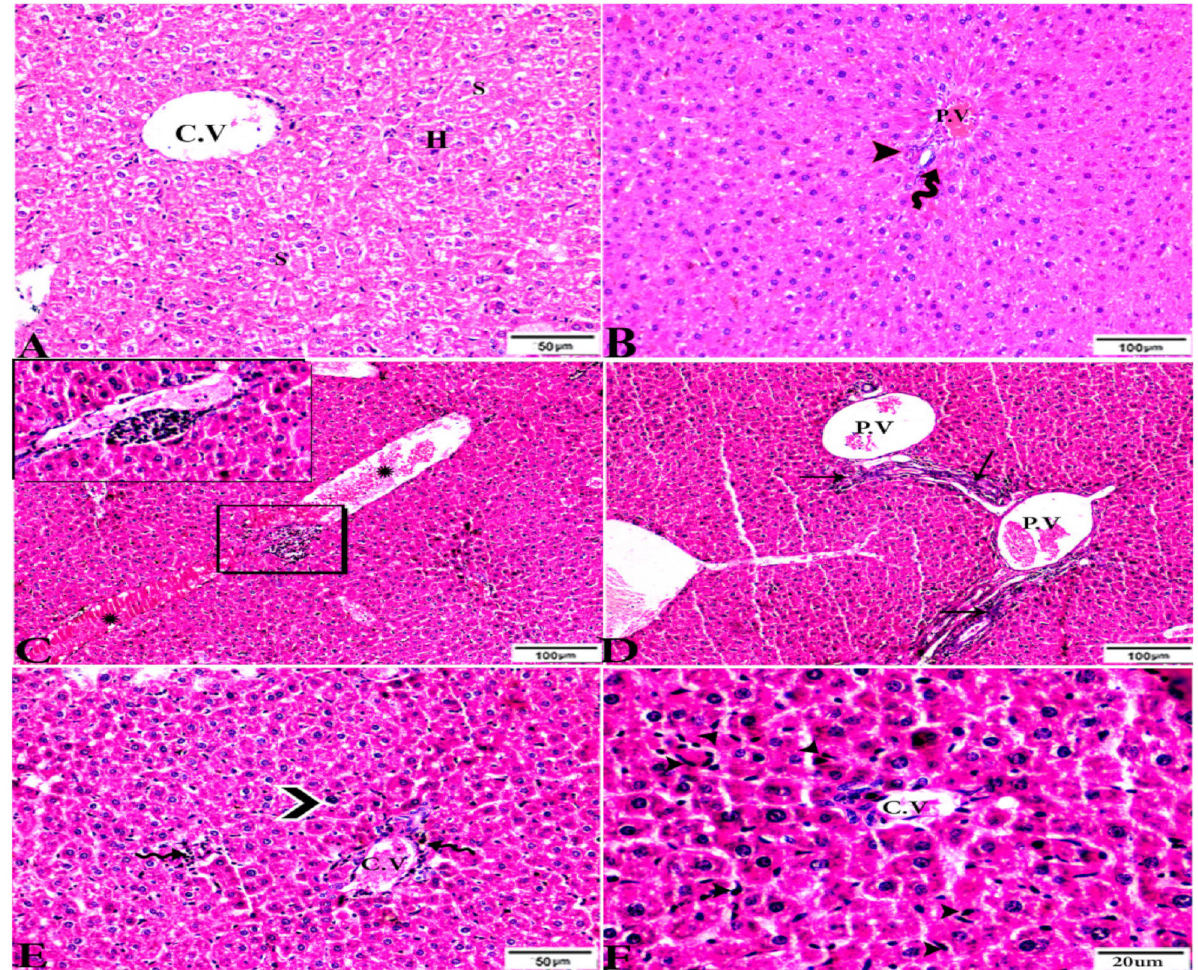
Figure 3. Photomicrograph of H&E-stained liver tissue sections from mice in the experimental groups: ( A , B ): Liver sections from the negative control group (G1) demonstrating: ( A ): normal hepatic archi- tecture comprising a normal central vein (C.V), sinusoids (S), and hepatocytes (H); and ( B ): normal portal triad structures: hepatic artery (arrowhead), portal vein (P.V), and bile duct (zigzag arrow). ( C – F ): Liver tissue sections from mice in the Toxoplasma gondii -infected positive control group (G2) showing: ( C ): severe vascular congestion (stars), focal mononuclear cellular aggregations (selected squares), and coagulative necrosis in hepatocytes; ( D ): dilated and congested PV, longitudinal fibrous tracts connected between P.V (arrows); ( E , F ): congested C.V, multiple bradyzoites (zigzag arrows), tissue cyst (arrowhead), and marked Kupffer cell reactions (E, arrowheads). The scale bar is provided below each